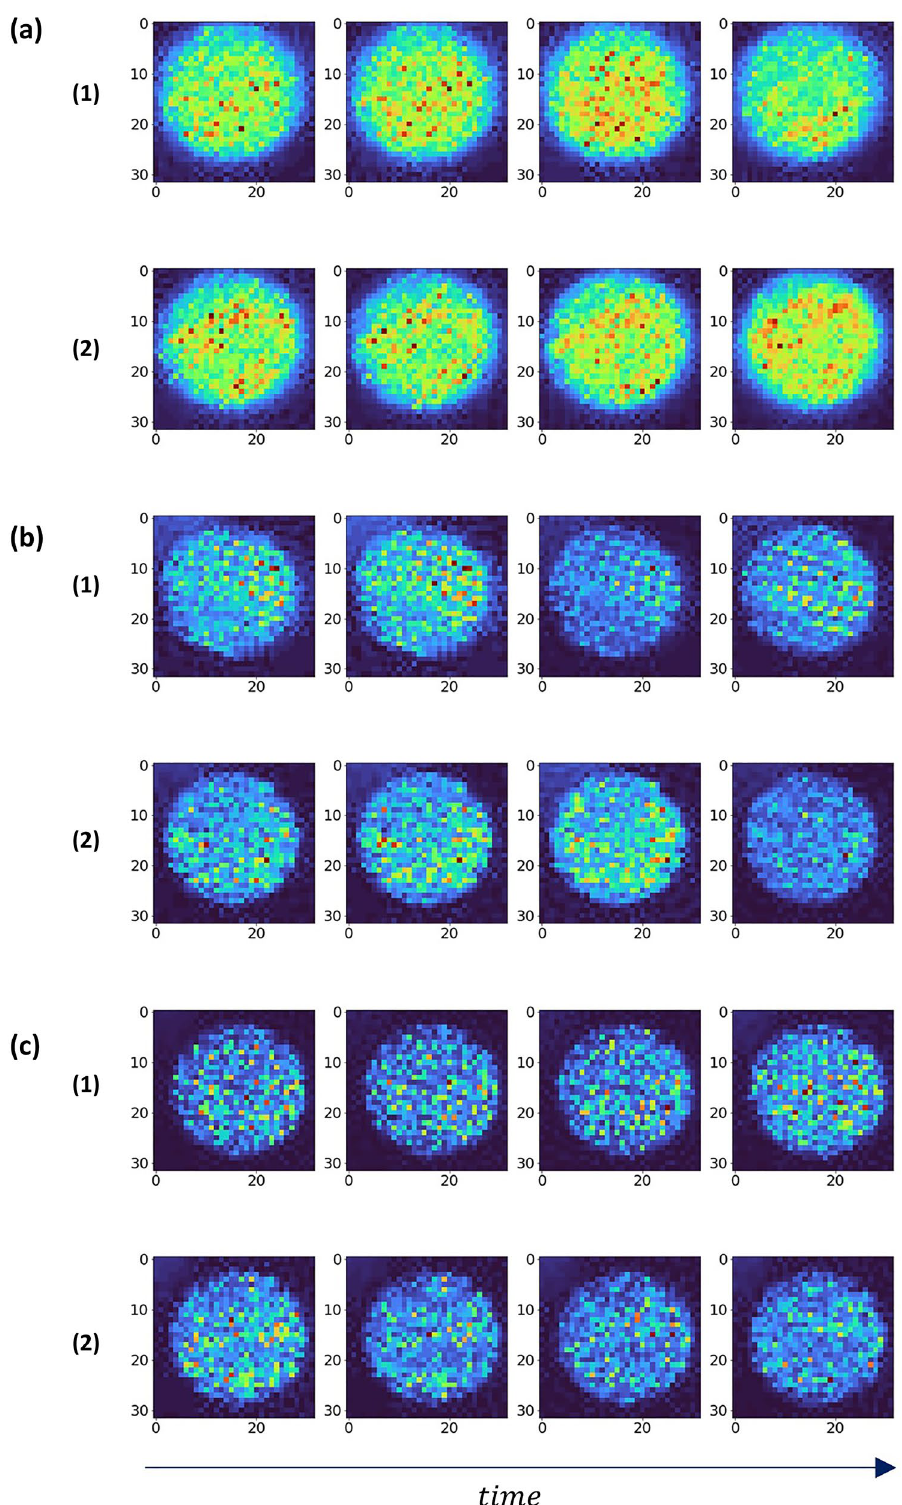
Figure 2. Sample frames from the dataset. ( a ) sample frames of smell sense. ( b ) sample frames of hearing sense. ( c ) sample frames of taste sense. For each sense (1) is representing frames of an active sense while (2) represents an inactive